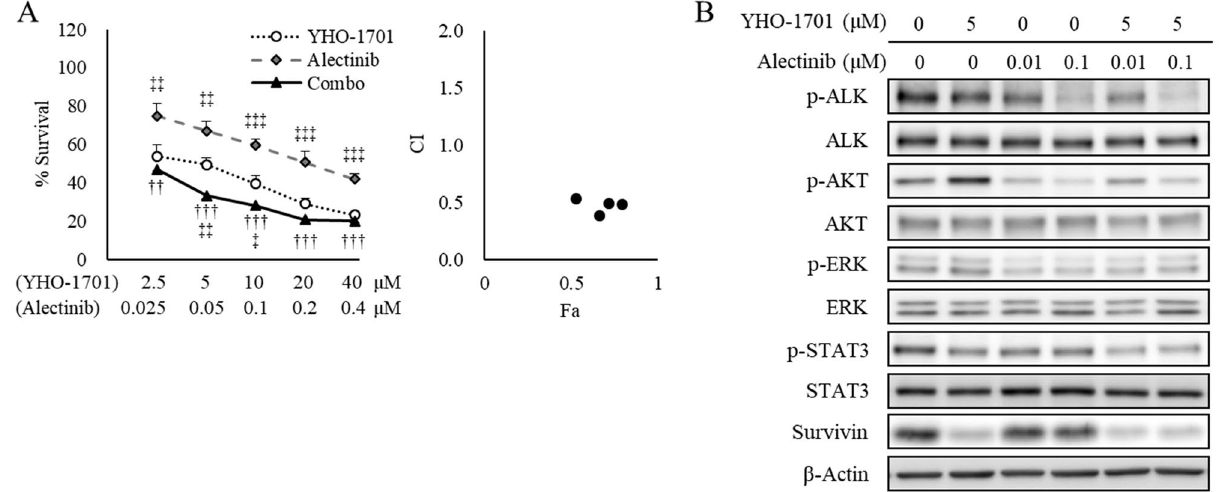
Figure 5. Synergism between YHO-1701 and alectinib in H2228 cells. ( A ) The antiproliferative effect of YHO-1701 and/or alectinib was investigated at 72 h of exposure. Dose–response curves are represented in the left panel. Combination index (CI) values are plotted as a function of fraction affected (Fa) in the right panel. Significance was determined with Tukey’s test. †† p < 0.01; ††† p < 0.001 versus the alectinib group. ‡ p < 0.05; ‡‡ p < 0.01; and ‡‡‡ p < 0.001 versus the YHO-1701 group. ( B ) Phosphorylation/activation patterns of key molecules on ALK and STAT3 signaling pathways were examined by western blotting. H2228 cells were left untreated or treated with YHO-1701 and/or alectinib at the indicated doses for 24 h. The blots were probed with the respective primary antibodies. Cropped images are shown, and full-length blots are presented in Supplementary Fig.